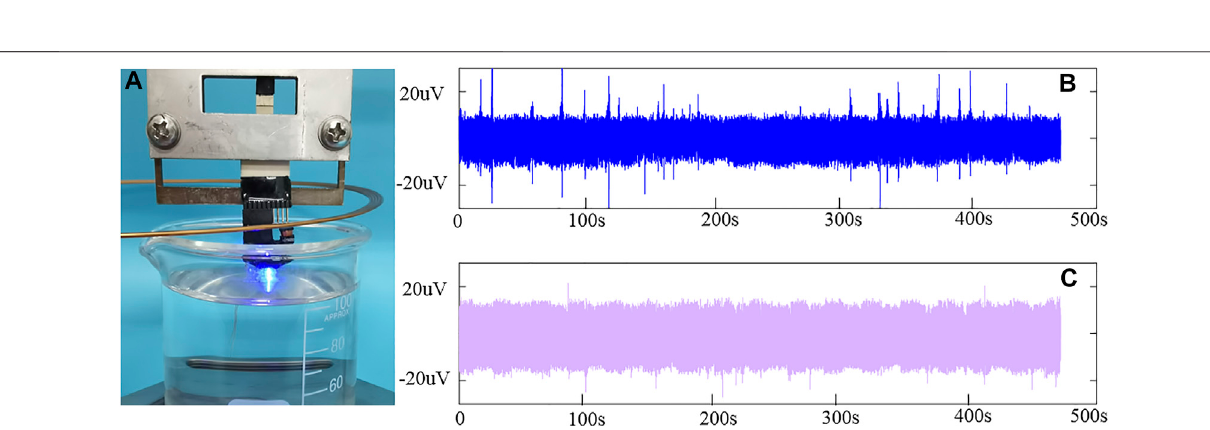
Frontiers in Nanotechnology |